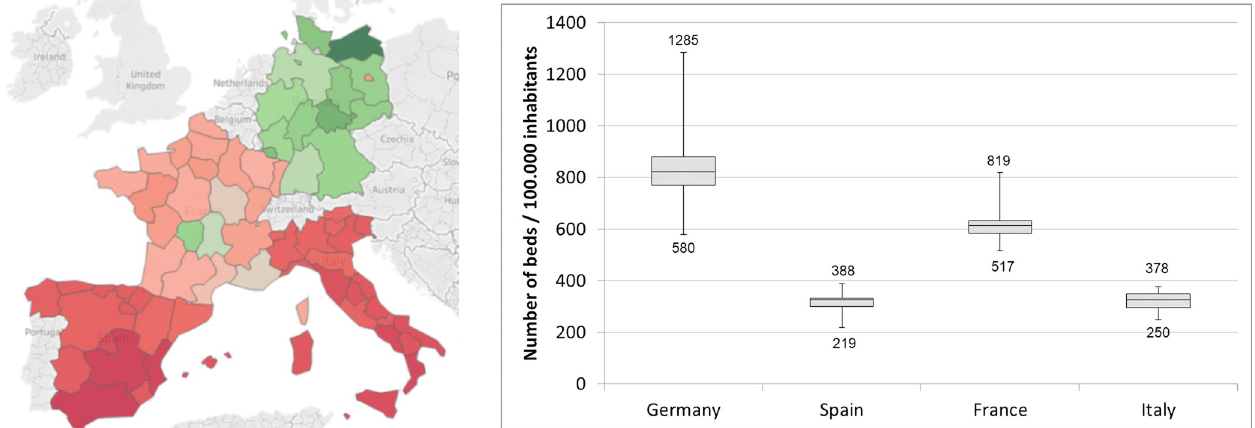
Fig 3. Number of hospital beds per 100.000 inhabitants: (a) Distribution by region (map) where the colours span from red to green to specify respectively regions with the highest and the lowest number of beds per 100.000 inhabitants (map was created on the basis of Eurostat data [23] using Tableau Software; Seattle, Washington, United States); (b) Numerical distribution for each nation .